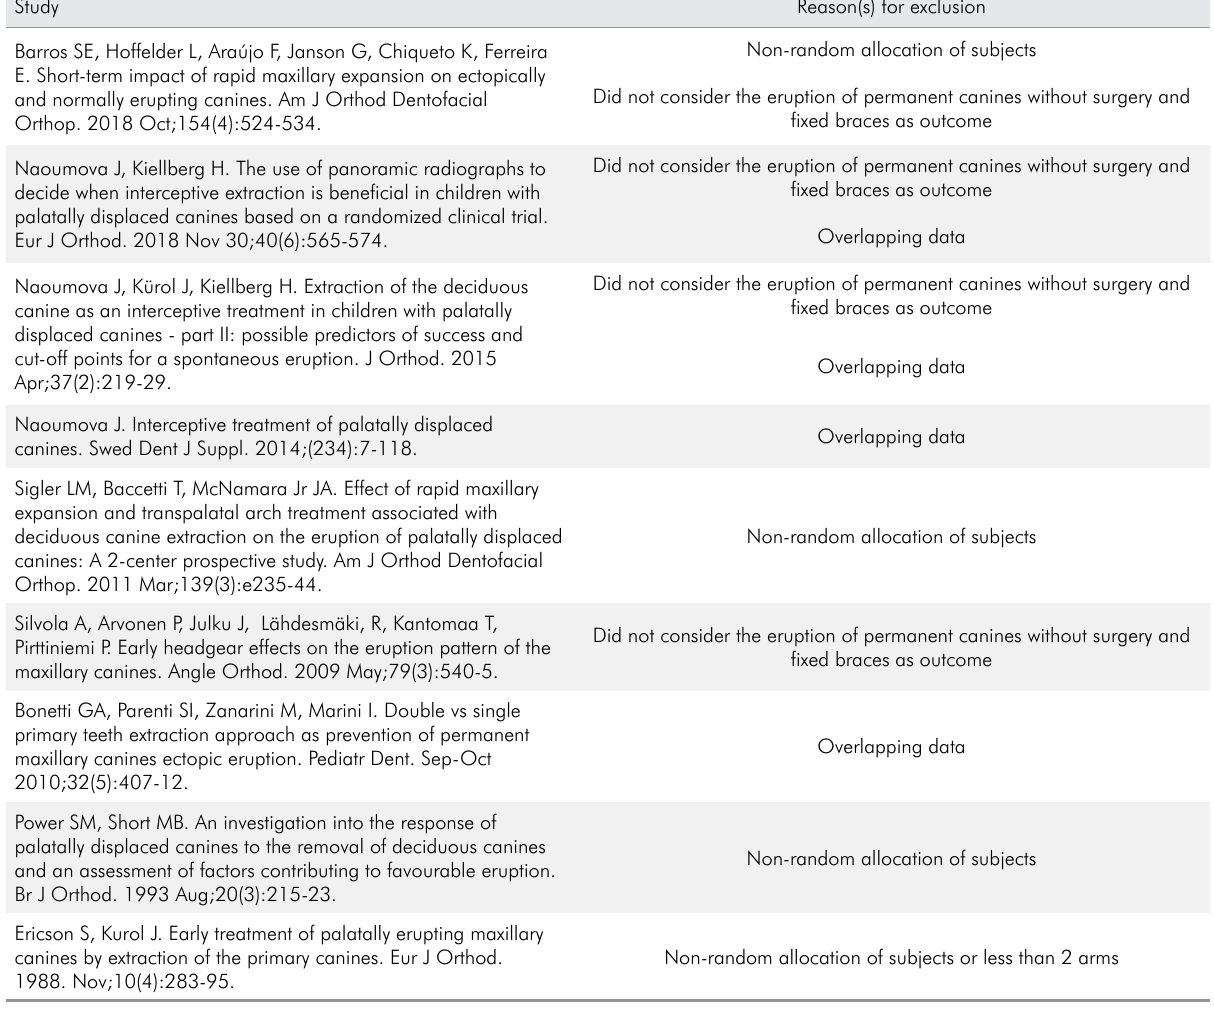
Table 2. Characteristics of excluded